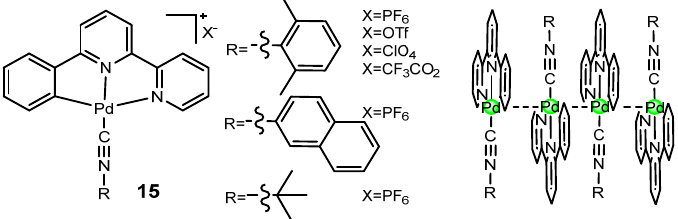
Figure 7. Chemical structures of the Pd(II) complexes and 1D in fi nite structure with a Pd(II)–Pd(II) chain with M–M interactions. Adapted from [66].